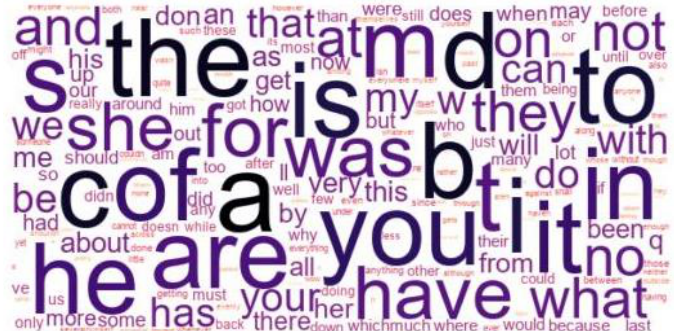
Figure 1. Word cloud of the function words.